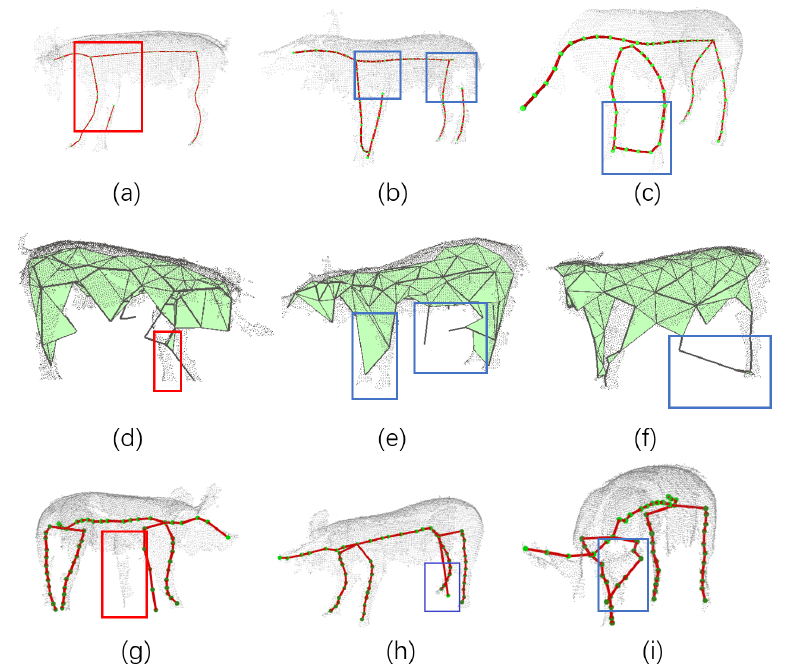
Figure 9. Detection errors and connection errors that occurred in the three methods. The results extracted by L 1 -median method, Point2skeleton method and our method are listed in the first row ( a – c ), second row ( d – f ), and third row ( g – i ), respectively. Detection errors are labeled in red. Connection errors are labeled in